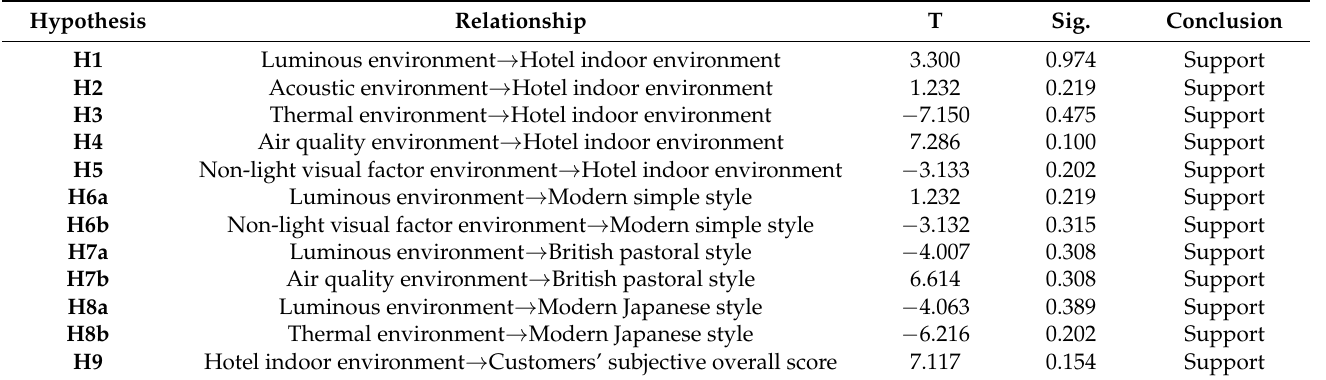
Table 7. Hypothesis test results.